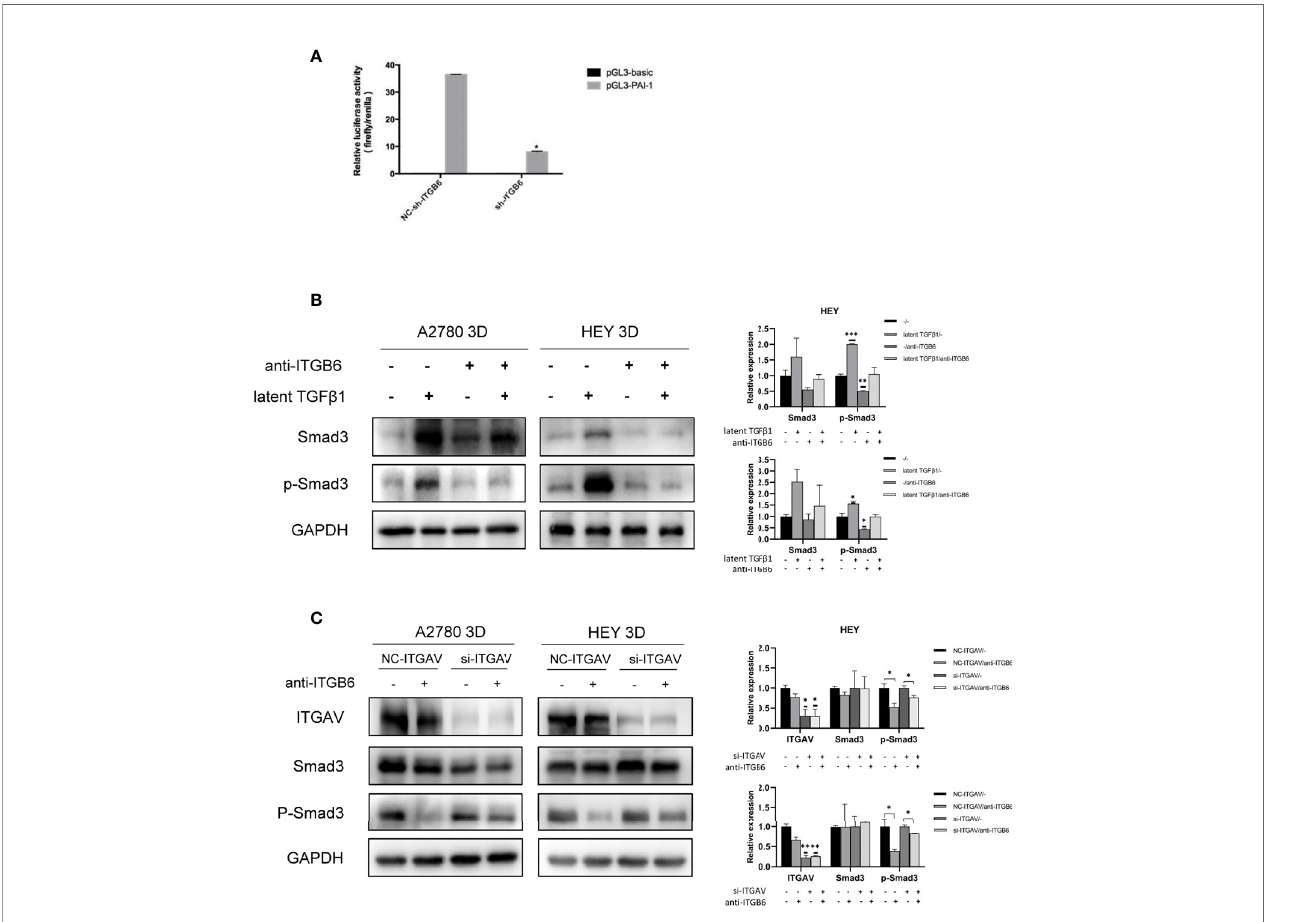
FIGURE 4 | Latent TGF b 1 can bind to ITGB6 and release active TGF b 1 to stimulate the Smad3 pathway. (A) A dual-luciferase reporter assay showed changes in 3D-cultured HEY cells after ITGB6 silencing. (B) Changes in the phosphorylation level of Smad3 in 3D-cultured HEY and A2780 cells after treatment with or without latent TGF b 1 and anti-ITGB6 antibody. Anti-ITGB6 antibody (10 m g/ml) was added to the culture medium as a pretreatment to block ITGB6 for 12 h. Then, 10 ng/ml latent TGF b 1 was added to the culture medium for 72 h (equal doses of normal mouse IgG1 and PBS were used as the negative controls for the anti-ITGB6 antibody and latent TGF b 1, respectively). (C) Changes in the phosphorylation level of Smad3 in 3D-cultured HEY and A2780 cells after silencing of ITGAV. NC-ITGAV and si-ITGAV were transfected into HEY and A2780 cells. After 6 h, the cells were resuspended in ultralow-attachment plates for 3D culture. Then, 10 m g/ml anti- ITGB6 antibody was used to block ITGB6 for 12 h in 3D-cultured NC-ITGAV and si-ITGAV cells, and equal doses of normal mouse IgG1 were used as a negative control. Subsequently, 10 ng/ml latent TGF b 1 was added to the culture medium and incubated for 72 h in each group. In the histogram of the quanti fi cation, “ * ” refers to p < 0.05, “ ** ” refers to p < 0.01, and “ *** ” refers to p <